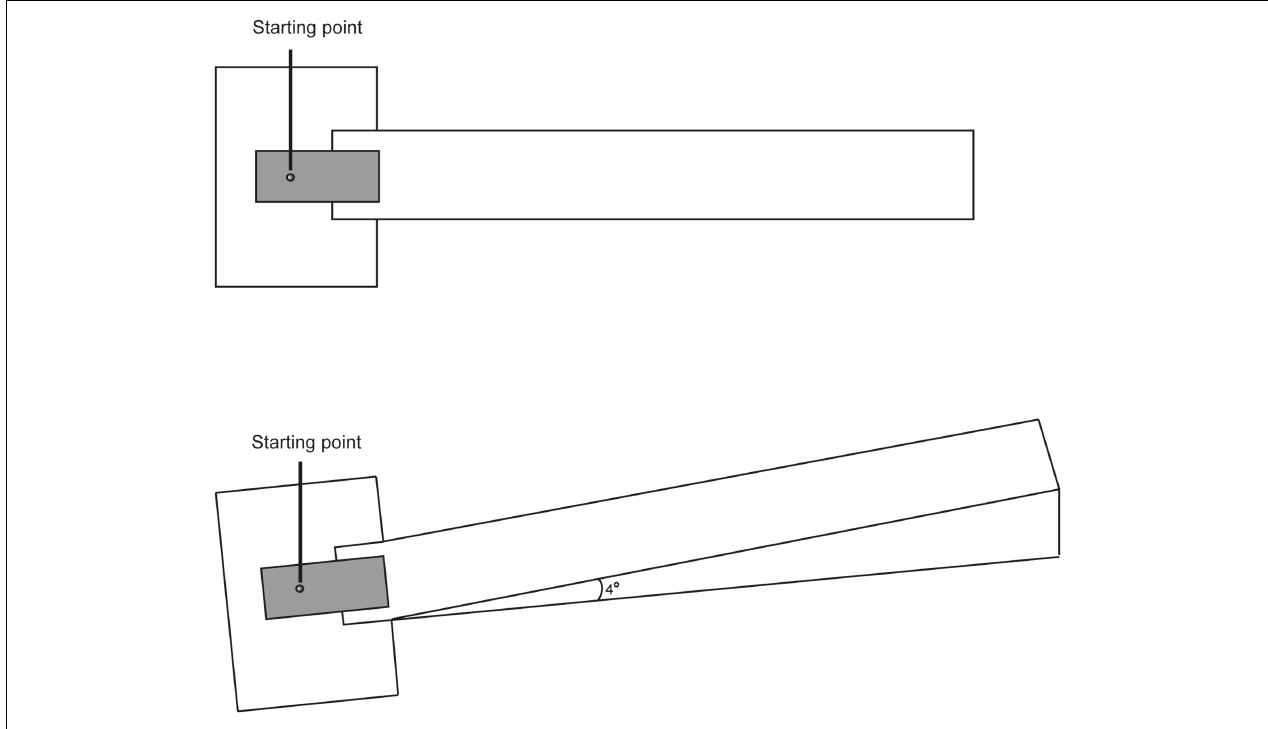
FIGURE 4 | Laboratory setup. The uphill surface had an angle of inclination of